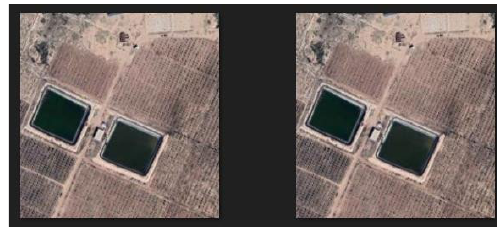
Figure 2. High-resolution compressed